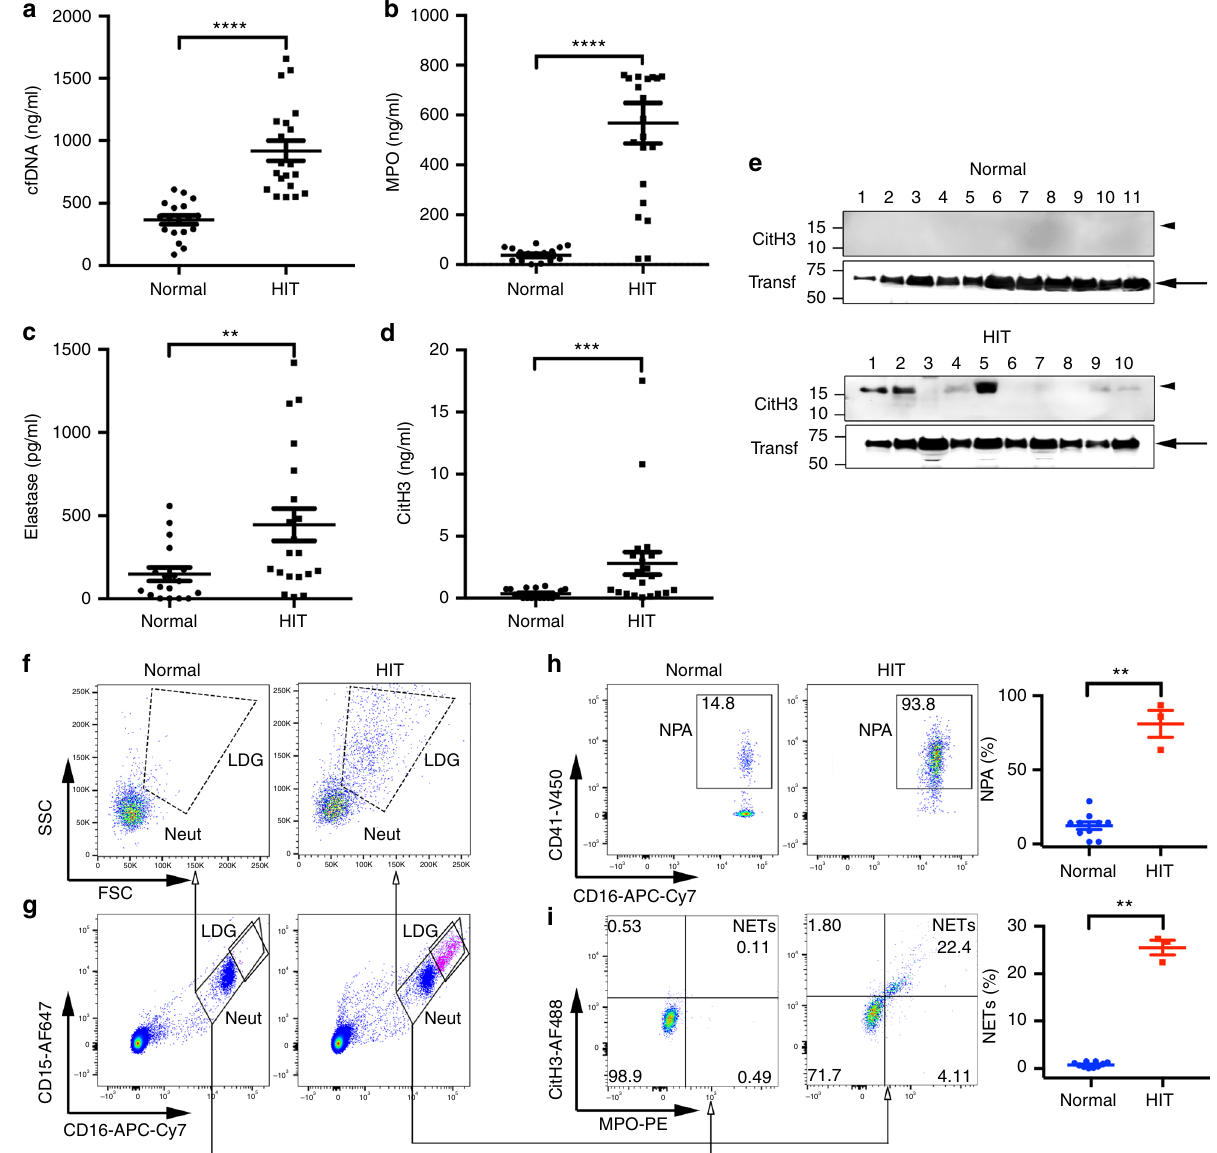
Fig. 1 NETs are present in HIT patients. a cfDNA in HIT patients ’ plasma ( n = 21) relative to normal controls ( n = 18) was detected using PicoGreen dsDNA fl uorescence assay. b MPO levels in HIT patients ’ plasma ( n = 21) and normal controls ( n = 18) were measured by ELISA. c Neutrophil elastase concentration in patients ’ plasma ( n = 20) relative to normal controls ( n = 18) and d CitH3 levels in HIT patients ’ plasma ( n = 21) relative to normal controls ( n = 18) was determined by ELISA. e Western blot images of CitH3 probed with anti-CitH3 antibody in normal controls and HIT patients ’ plasma. Each lane represents a different donor ’ s plasma. Transferrin (Transf) was used as a loading control. Arrowhead indicates CitH3 band. Arrow